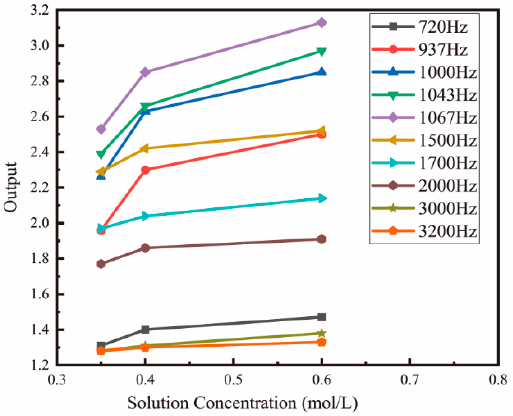
Figure 7. The relationship between concentration and the circuit output at different frequencies. From 720 Hz to 3200 Hz, the frequency is adjusted by dichotomy to determine the optimal excitation frequency.